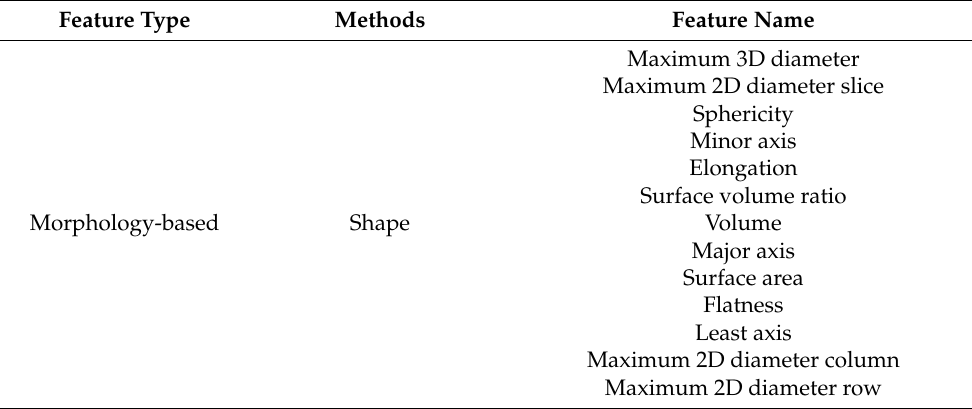
Table 2. Feature type and associated features.